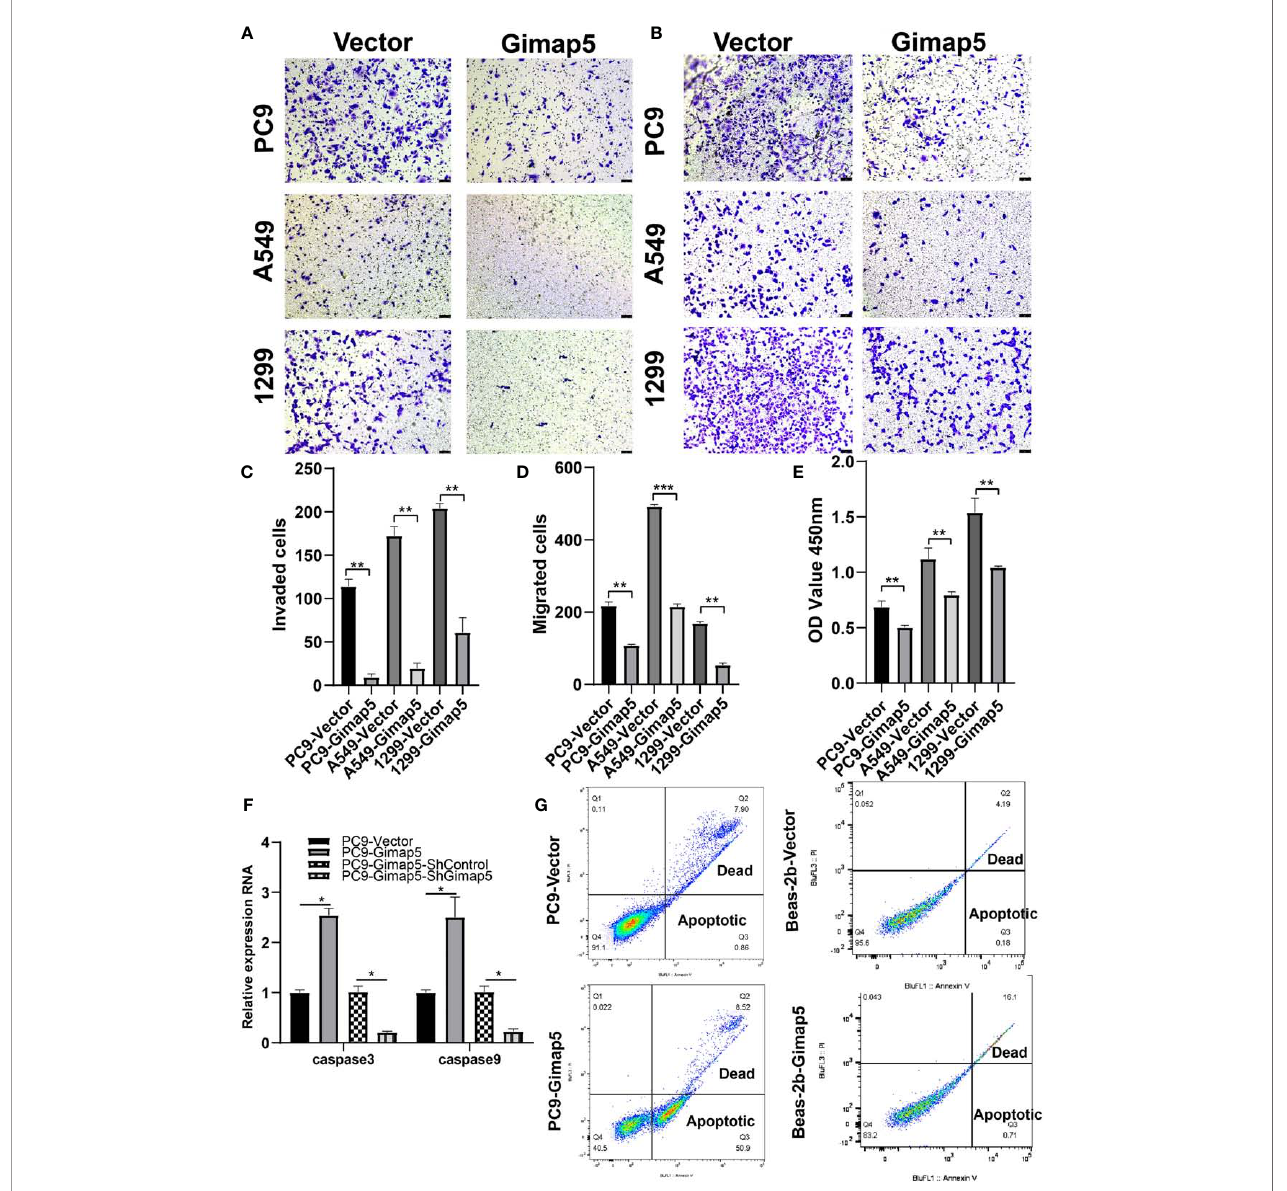
FIGURE 3 | Gimap5 inhibited migration, invasion and proliferation and promoted apoptosis of lung cancer cells (n = 3). (A) Gimap5 overexpression inhibited the invasion of all three cancer cell lines using Transwell assay. (B) Gimap5 overexpression inhibited the migration of all three cancer cell lines using Transwell assay (magni fi cation, ×100). (C, D) The numbers of invading and metastasized cells were measured by Image J and represented by bar graph. (E) Gimap5 overexpression inhibited the proliferation of all three cancer cell lines using CCK-8 assay. The data were expressed as mean ± SEM (** p < 0.01 and *** p < 0.001 vs . empty vector) of the three independent experiments. (F) Gimap5 overexpression promoted apoptosis. After overexpression of Gimap5, the mRNA expression levels of caspase3 and caspase9 were up-regulated (*p < 0.05 vs. empty vector). After knockout of Gimap5, the mRNA expression levels of caspase3 and caspase9 were down-regulated (*p < 0.05 vs. shControl). (G) Flow cytometry showed that overexpression of Gimap5 signi fi cantly increased cell apoptosis in PC9 cells, however, there was no signi fi cant change in Beas-2b cells. In the scatter plot of the bivariate fl ow cytometer, the lower left quadrant shows living cells, which is (FITC - /PI - ); The upper right quadrant is non-living cells, i.e. necrotic cells, and is (FITC + /PI + ); The lower right quadrant is apoptotic cells, showing (FITC + /PI -